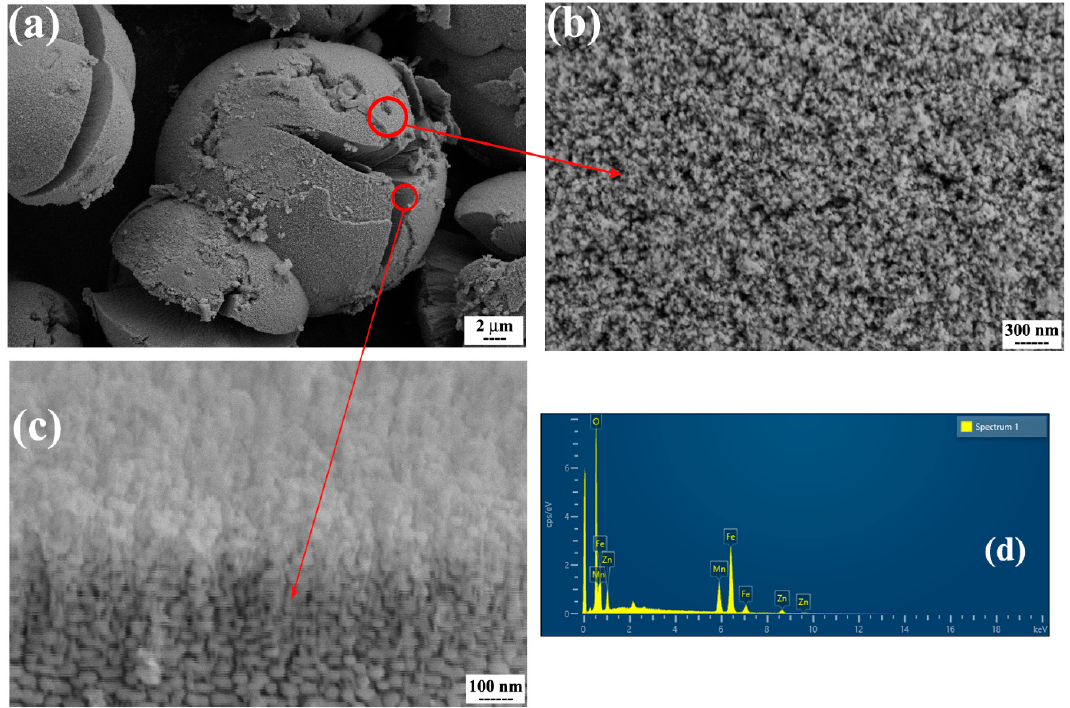
Figure 2. ( a , b ) SEM micrographs of synthesized MnZn ferrite with normal morphology at di ff erent magni fi cations, and ( c ) corresponding EDS results.